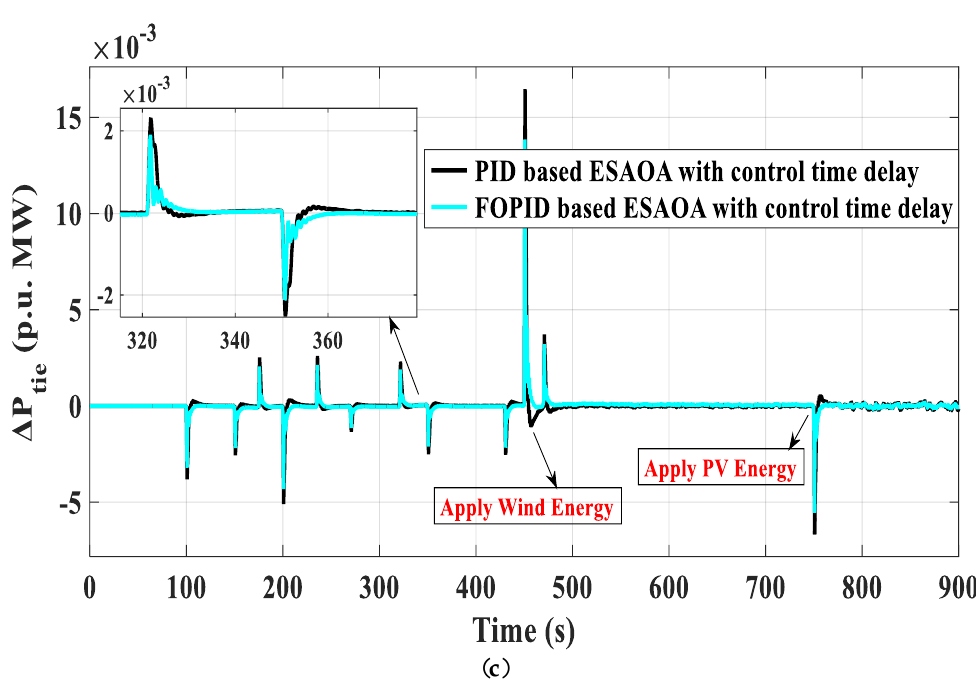
Figure 22. Dynamic system response of scenario C with random load variation at area-1, wind energy at t = 450 s at area-1, and PV at t = 750 s at area-2 considering communication time-delay ( a ) ∆𝑓 1 , ( b ) ∆𝑓 2 , and ( c ) ∆𝑝 𝑡𝑖𝑒 .